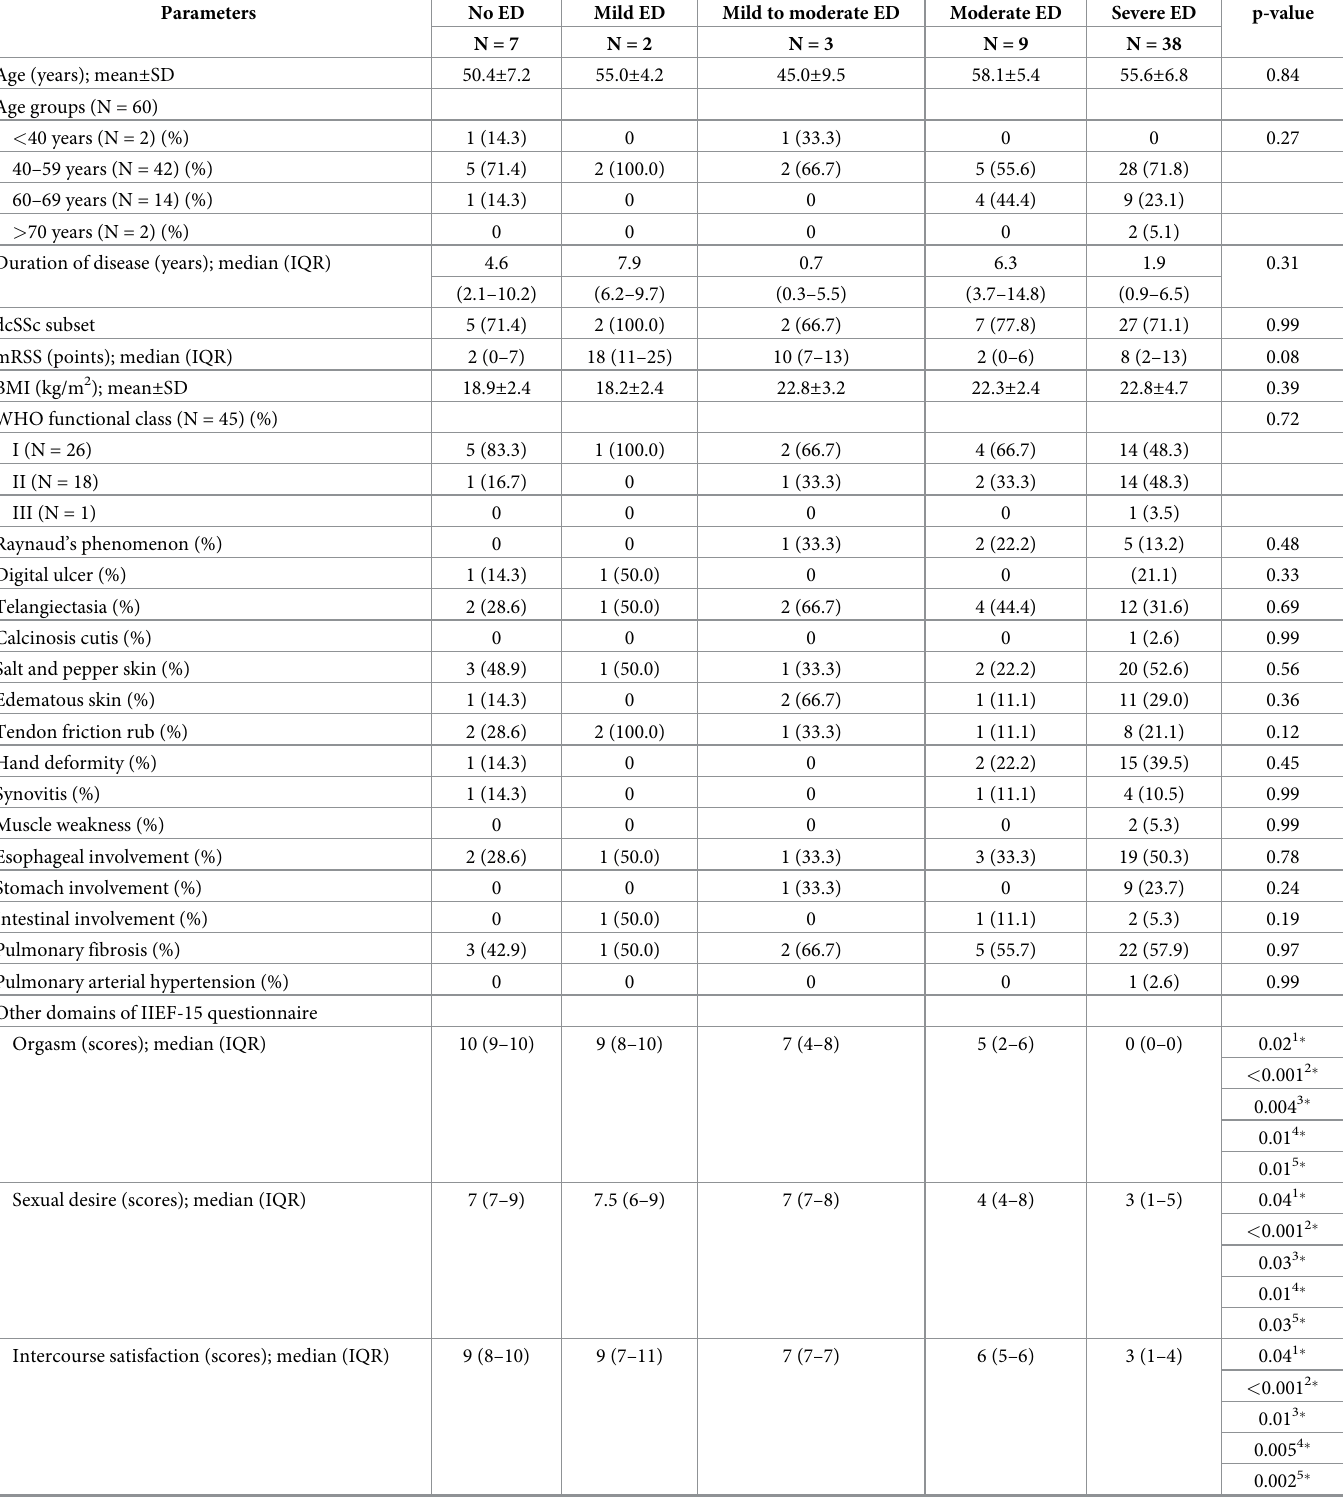
Table 2. Clinical differences categorized by severity of